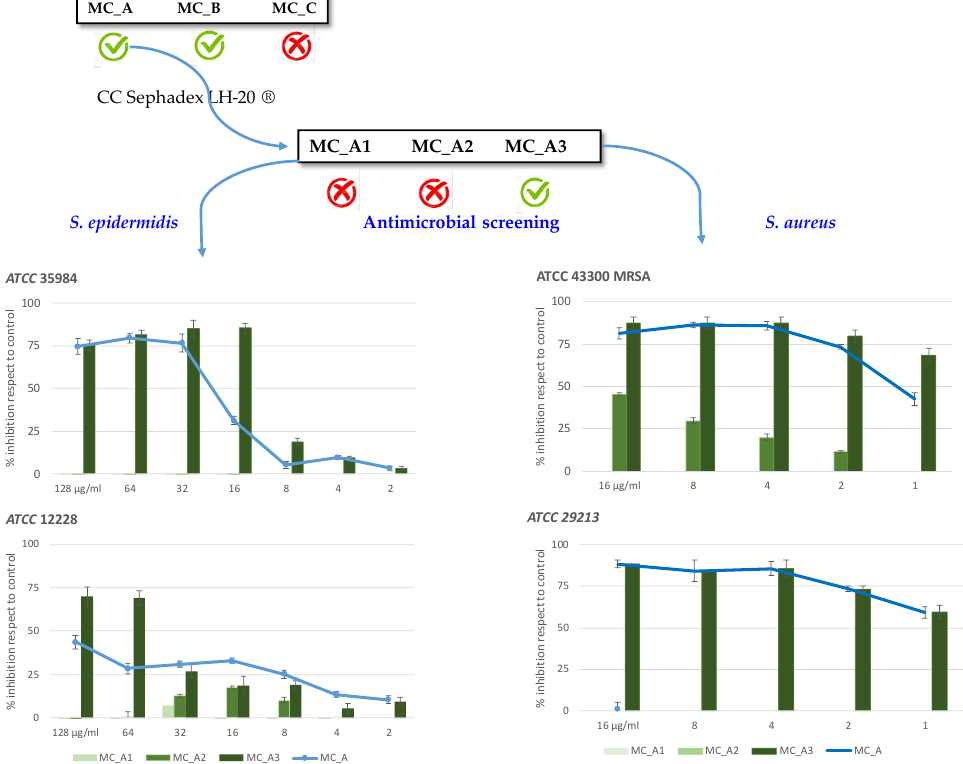
Figure 2. Purification and antimicrobial assessment of MC_A derived fractions (MC_A1, MC_A2, MC_A3) against S. epidermidis and S. aureus